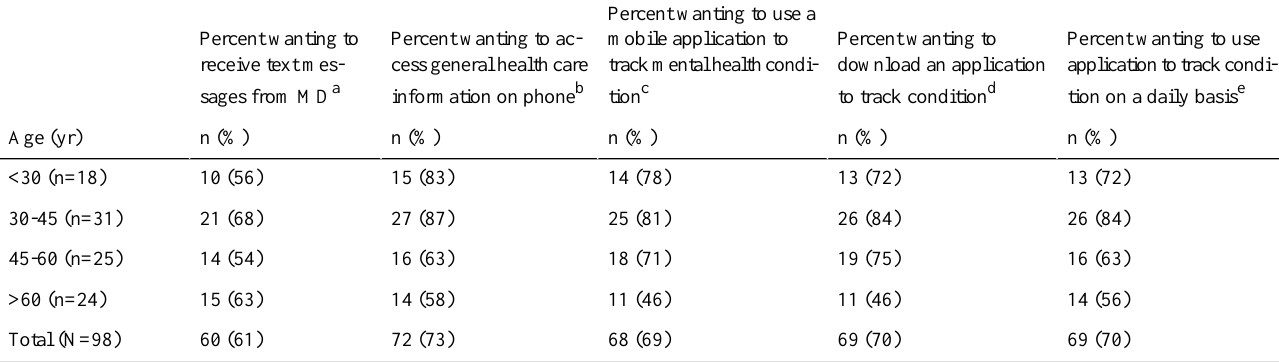
Table 5. Interest in using text messages and smartphone applications for mental health